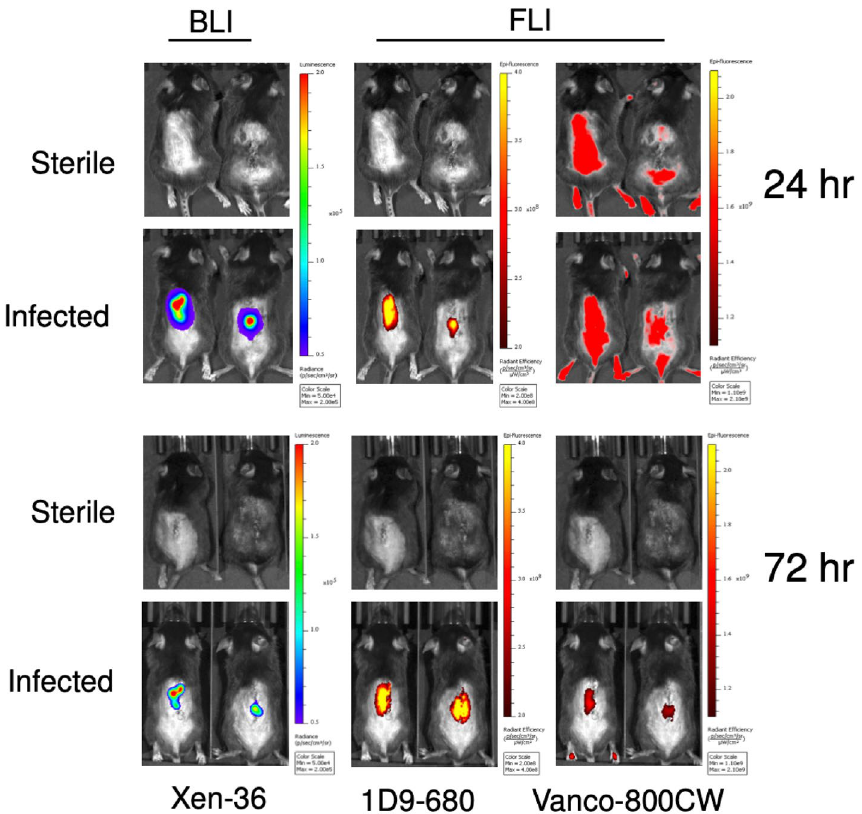
Figure 3. Bioluminescence and fluorescence images of mice with spinal implant infection at 24 h and 72 h post probe injection (PI). Bioluminescence imaging of two representative mice reveals bacterial signal